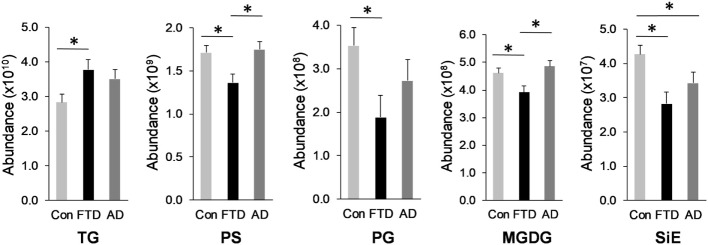
Lipids that were significantly altered in behavioral variant frontotemporal dementia. Total relative abundance of lipids following multivariate analyses covarying for age and gender; Data represent mean and SE as error bars, *p < 0.05. TG, triglyceride; PS, phosphatidylserine; PG, phosphatidylglycerol; MGDG, monogalactosyldiacylglycerol; SiE, sitosteryl ester.